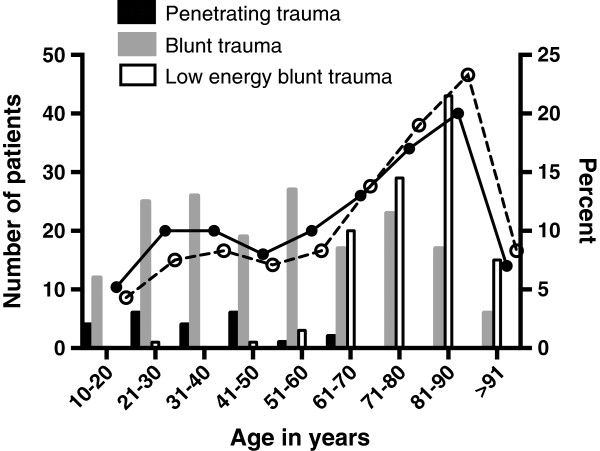
Number of deaths from penetrating (n = 23), blunt (n = 172) and low energy blunt trauma (n = 112) and percentage of all deaths (• symbol and solid line) and all deaths excluding patients DOA (ο symbol and dotted line) versus age group.